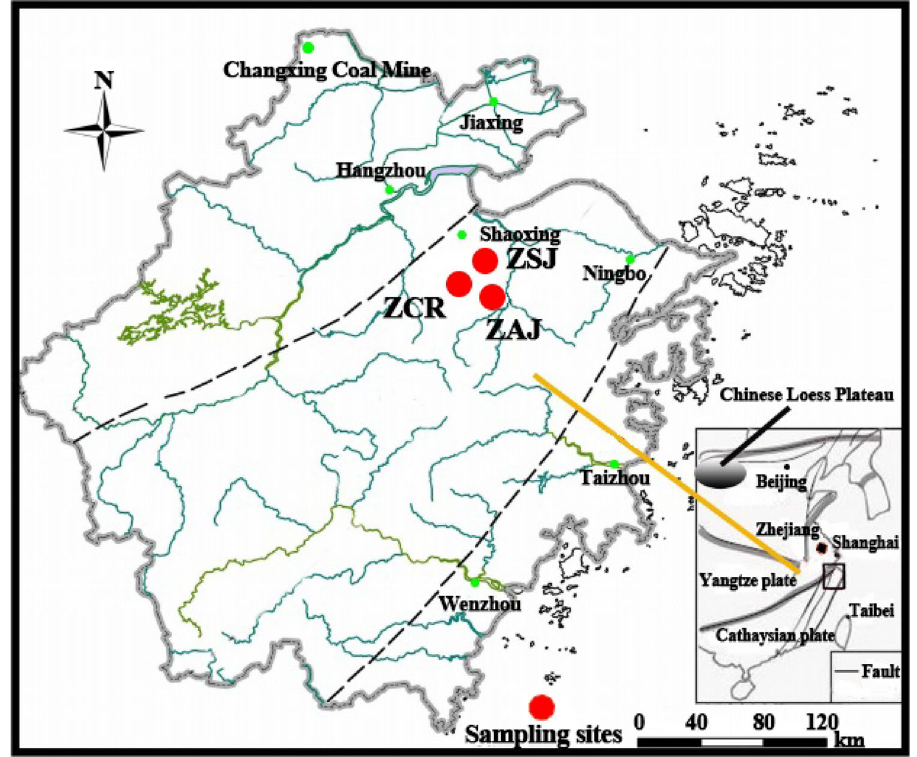
Figure 1. Pb content and 206 Pb/ 207 Pb ratios for soils in Southeast China.